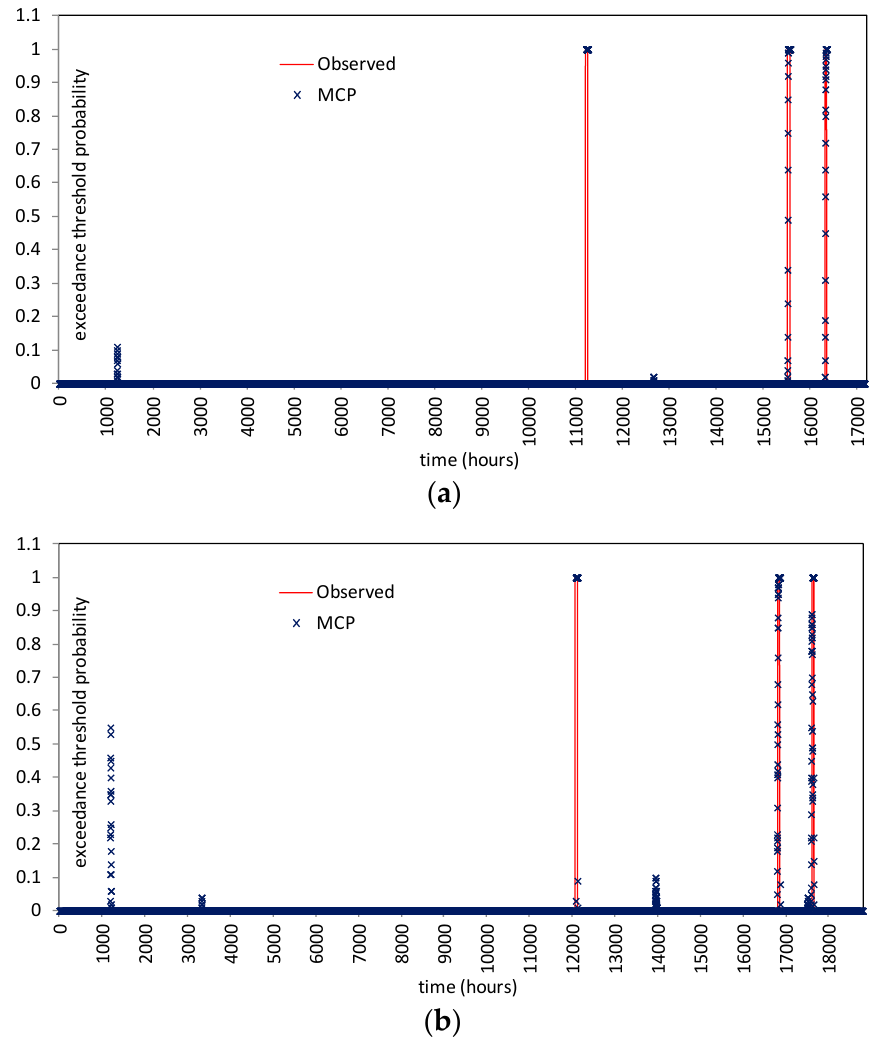
Figure 10. Polavaram section (warning threshold = 14.27 m): comparison between the observed exceedance threshold probability and the one computed by the MCP-MT within: ( a ) the next 12 h (reach 1); and ( b ) the next 24 h (reach 2) for all the available dataset. To investigate the benefit of the ETP estimate, a deep analysis on selected flood events is also shown in Figure 11 for the reach 2 case study and the longer lead-time equal to 24 h that represents the best information that could be provided to decision-makers. The analysis consists in comparing the binary observed exceedance (equal to 1 when the observed stage is above the threshold level and equal to 0 when it is below) and the exceeding probability computed by the MCP-MT within the selected forecast lead-time period (24 h) that is varying over time. For sake of completeness, the binary response of the deterministic model, that can be equal to 1 or 0, is also considered in the analysis. Figure 11a,b, which concerns two high flood events occurred at Polavaram section, shows the benefit obtainable using the PU estimate. Specifically, these figures effectively show the advantage of using probabilistic approaches able to provide probabilities in the range of 0–1 and not only the binary values 0/1, corresponding to the condition of threshold